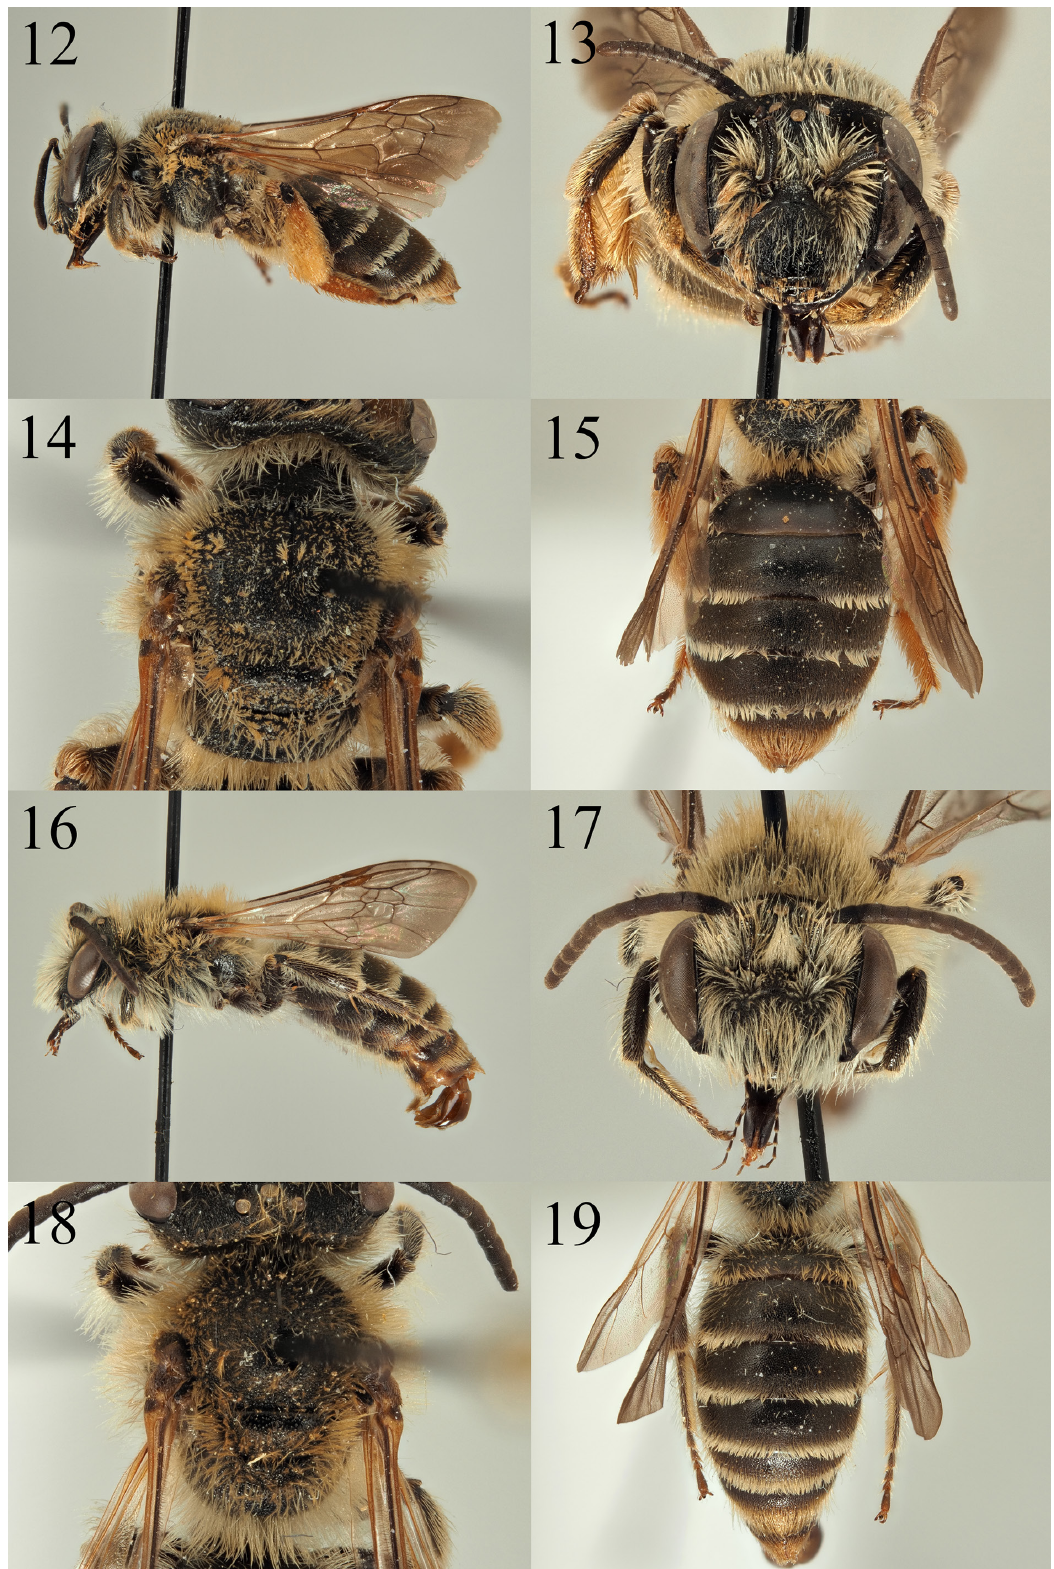
Figs 12–19. Andrena levante Wood & Praz sp. nov. (TJWC). 12 . Female profile. 13 . Female face. 14 . Female scutum. 15 . Female terga. 16 . Male profile. 17 . Male face. 18 . Male scutum. 19 . Male